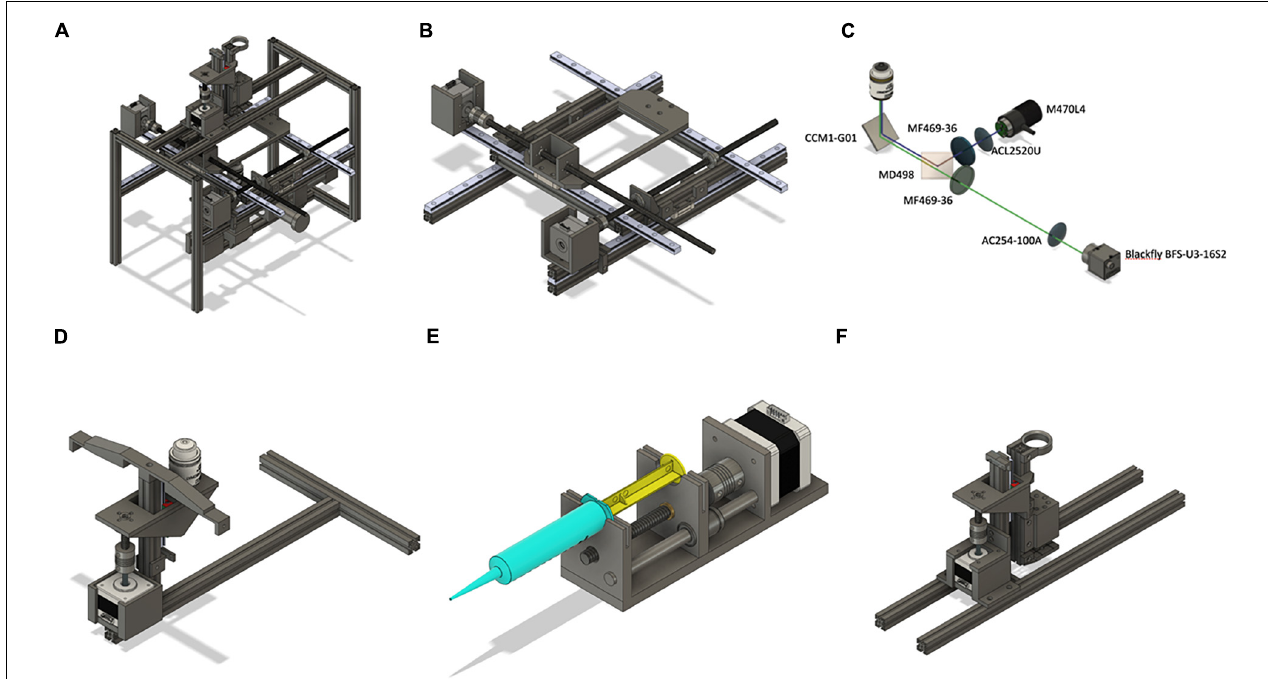
FIGURE 3 | Overview of the hardware design. (A) Assembled hardware consists of three modules: XY platform moving in horizontal directions; perfusion manifold moving up and down, epifluorescent microscope with a Z-stage. (B) The XY-stage consists of two side frames made of aluminum extrusions. Two long horizontal extrusions hold MGH12 rails forming the x -axis. A Nema 17 motor is attached to the side frame and moves the plate along the x -axis. Rotation of the stepper motor moves the leading screw that is attached to either the top platform or to a plate holder. The Y stage is based on an aluminum frame holding the plate holder. The y -axis motor is attached directly to one of the rails. (C,D) Optical design of the microscope and the autofocusing system. Numbers represent Thorlabs (all optics) and FLIR (camera) item numbers. The system implements a standard inverted fluorescent microscope with the objective attached separately to a vertically oriented linear actuator driven by a Nema 17 motor (D) . (E) Design of a syringe pump. The main platform holds one Nema 17 motor, lead screw, and an 8-mm rod. The moving part represents a holder for a nut and linear bearing. (F) Perfusion manifold for eight syringe pumps. Manifold holds eight pipette tips with one connected to the peristaltic pump. The latter is located slightly higher than others, which helps to keep the volume in each well constant. The manifold is fixed on a linear actuator and is driven by a Nema 17 motor. The whole system is fixed on two long horizontal extrusions attached to the top of the main frame. Four white LEDs connected in series are attached to the bottom of the manifold to provide bright-field microscope